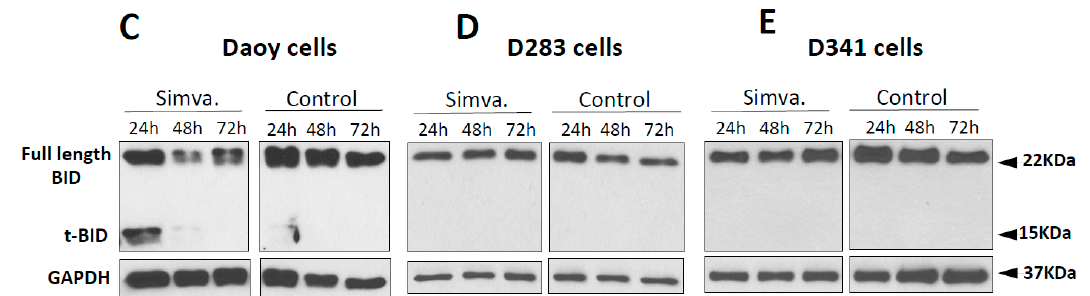
Figure 4. Simvastatin induces apoptosis via BID cleavage and caspase activities in Daoy cells. ( A , B ) Caspase activity in Daoy cells was measured by the Caspase Glow Assay kit at 48 h. The activity of caspase 8 is shown in A, and caspases 3/7 and caspase 9 are shown in B. Statistical significance is reported by unpaired t-test for caspase 8 activity and one-way ANOVA for caspase 3/7 and 9 using GraphPad Prism 7.0. The p -value is reported as **** p < 0.0001. Data are expressed as means ± SEM, and n = 9–10. ( C – E ) For Western blots, Daoy, D283, and D341 cells were collected at 24 h, 48 h, and 72 h. GAPDH (Glyceraldehyde 3-Phosphate Dehydrogenase) detection of the same membrane was used as a loading control. For the continuous full length-image of Western blot signals in Figure 4C–E, please refer to Supplementary Figure S2.